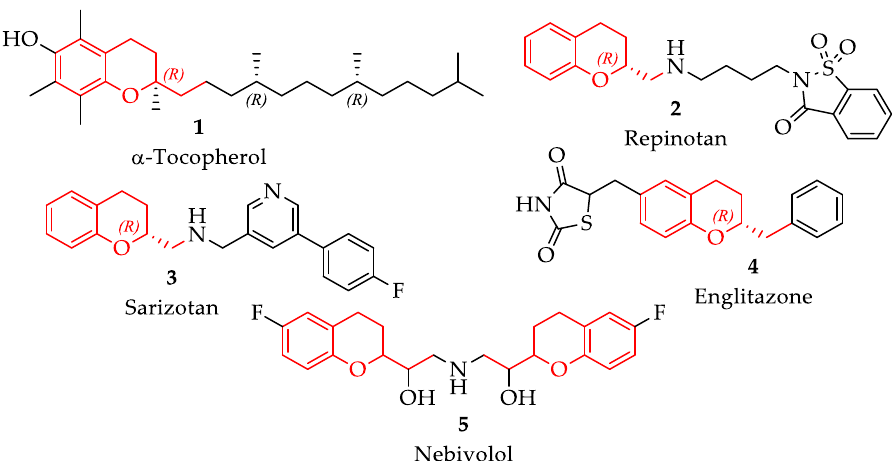
Figure 1. Representative bioactive 2-substituted